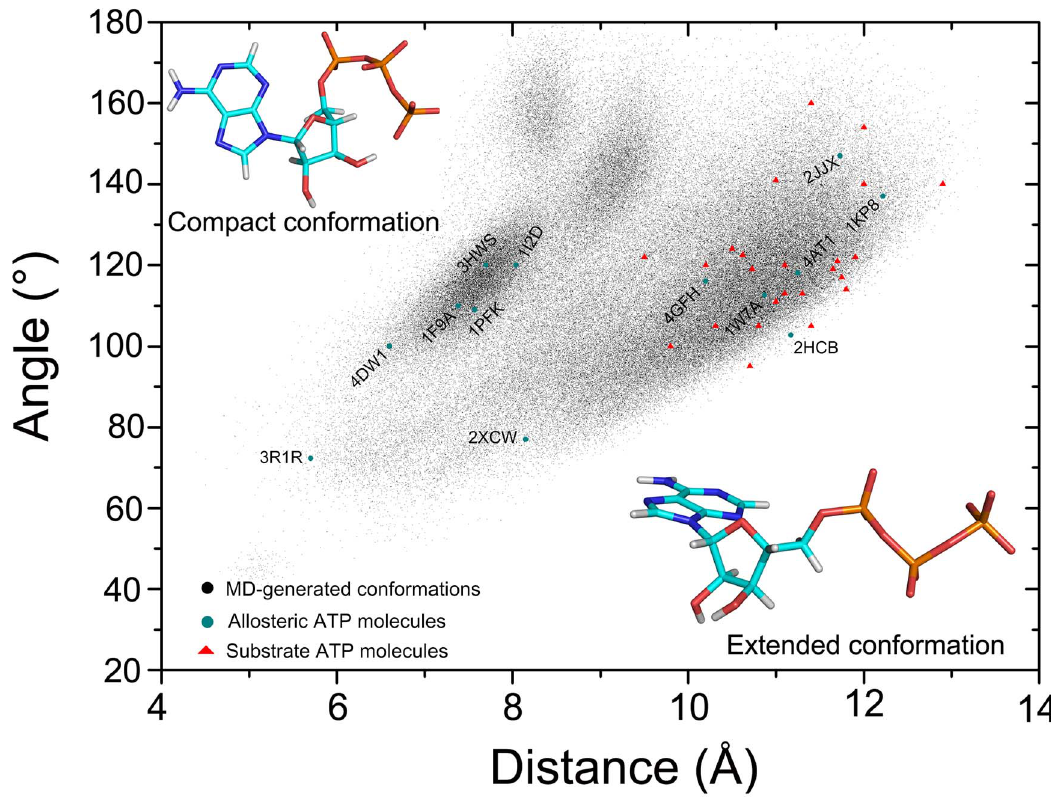
Figure 3. Comparison of conformational preferences of allosteric and substrate ATP molecules. The landscapes with the reaction coordinates of distance (defined by the distance from the P c atom to the centroid of adenine moiety) and angle (defined by the centroids of triphosphate, ribose and adenine moieties) were plotted on ATP conformations from the MD trajectory. The compact and extended structures of ATP correspond to the two major conformation regions. The bound ATP molecules in the allosteric and substrate datasets were mapped to the MD- generated ATP conformations.